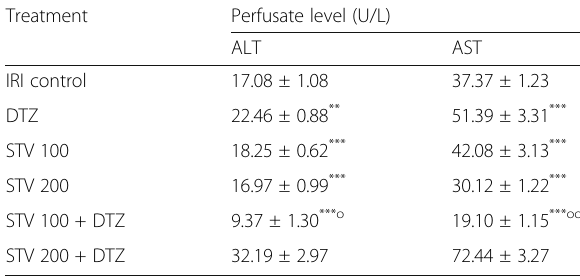
Table 4 Effect on STV, DTZ, and their combinations on perfusate biomarker levels in IRI Treatment